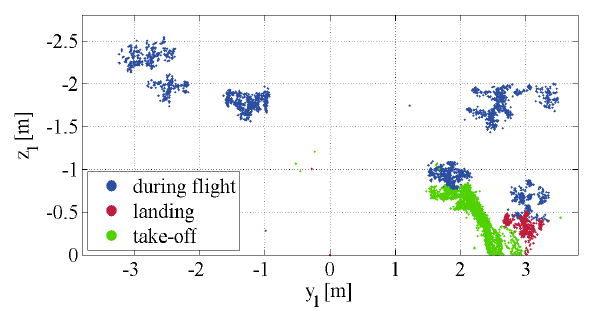
Figure 11: Laser scanner plane during the test flight A magnified section of previous figure is shown in Figure (12). The dimensions (0.6m length and 0.25m heigth) and contours of the quadrocopter can be seen clearly.